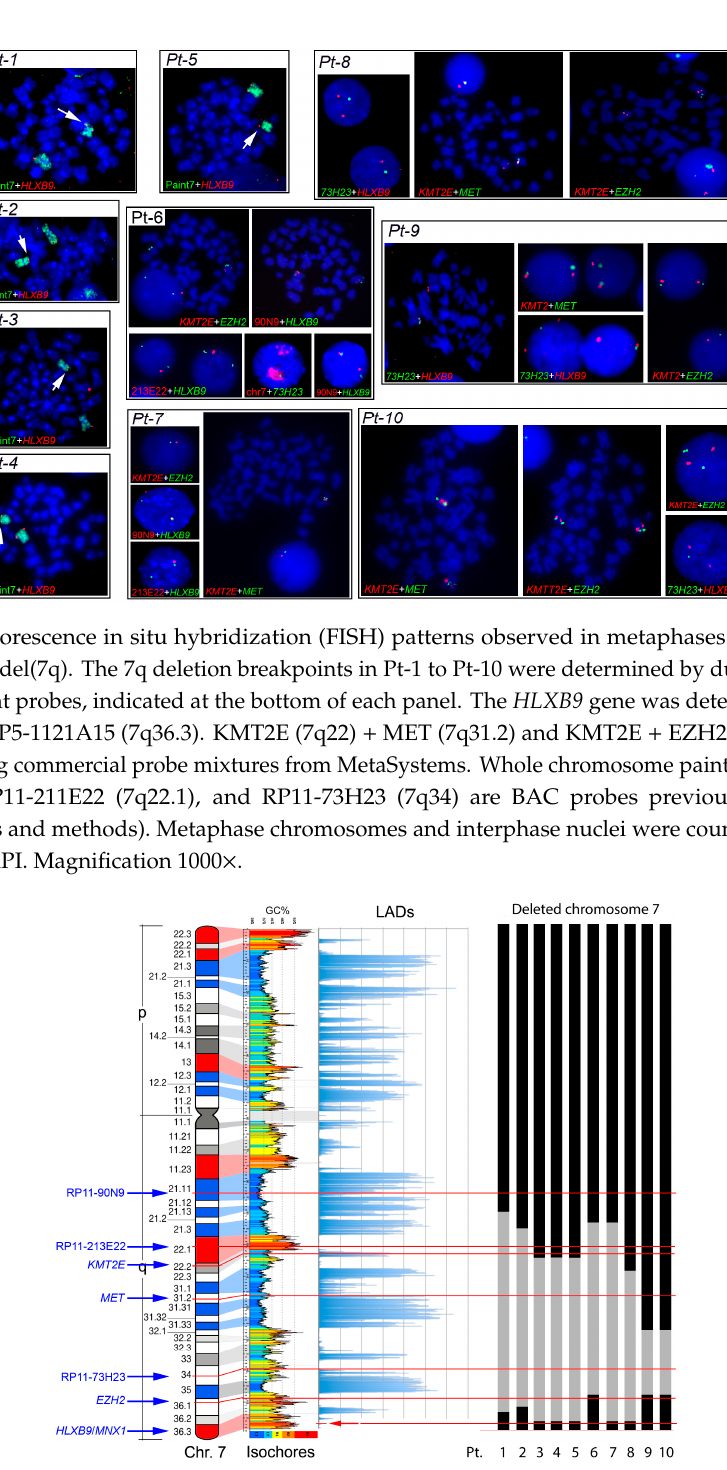
Figure 5. Genomic properties of chromosome 7 and the extent of the deleted region in the del(7q) patients. From left to right: Probes for the main landmarks used for FISH experiments, ideogram of the chromosome 7 showing the guanine-cytosine (GC)-richest (red) and the GC-poorest (blue) bands [10],correspondence with the GC-level of the genomic DNA sequence [62], distribution of the Lamina Associated Domains (LADs) along the chromosome [63], and schematic representation of the deleted region (in grey) in the del(7) chromosome detected in the ten subjects analyzed (Pt.: Patient number and deletion data from Table 1 and Table 2). The thin horizontal lines indicate the position of the probes indicated on the left.